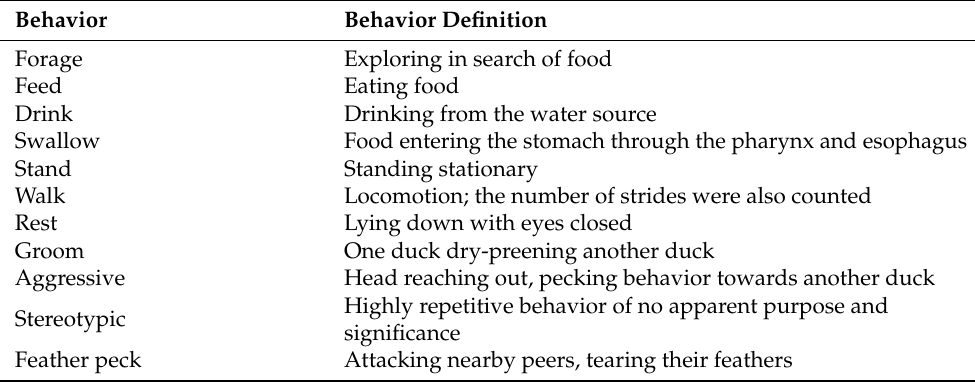
Table 1. Behavior ethogram of ducks.